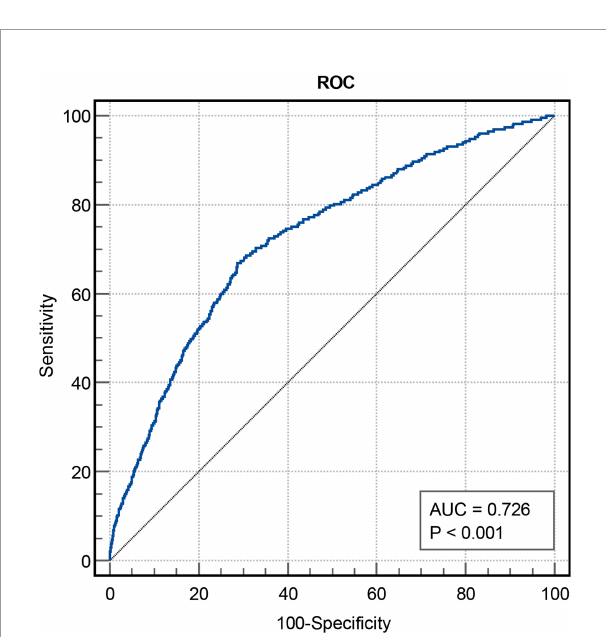
FIGURE 2 | The predictive values of TyG index for the risk of MACCEs. TyG, triglyceride-glucose; MACCEs, major adverse cardiovascular and cerebrovascular events; AUC, area under